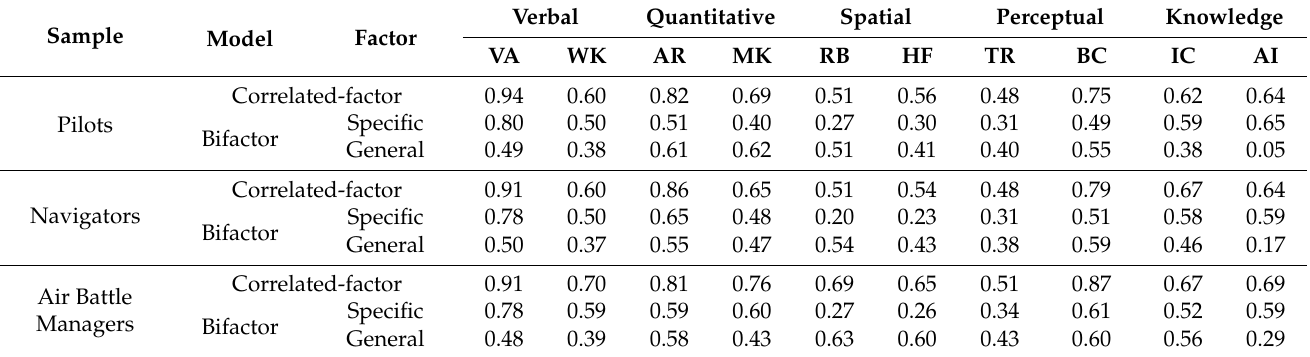
Table 2. Factor loadings from correlated-factor and bifactor models.